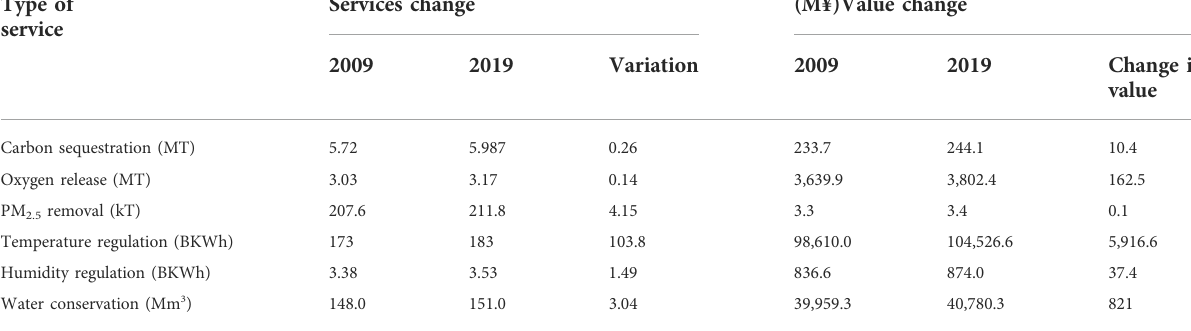
TABLE 3 Changes of ecosystem material quality and ecosystem service value in Lishui